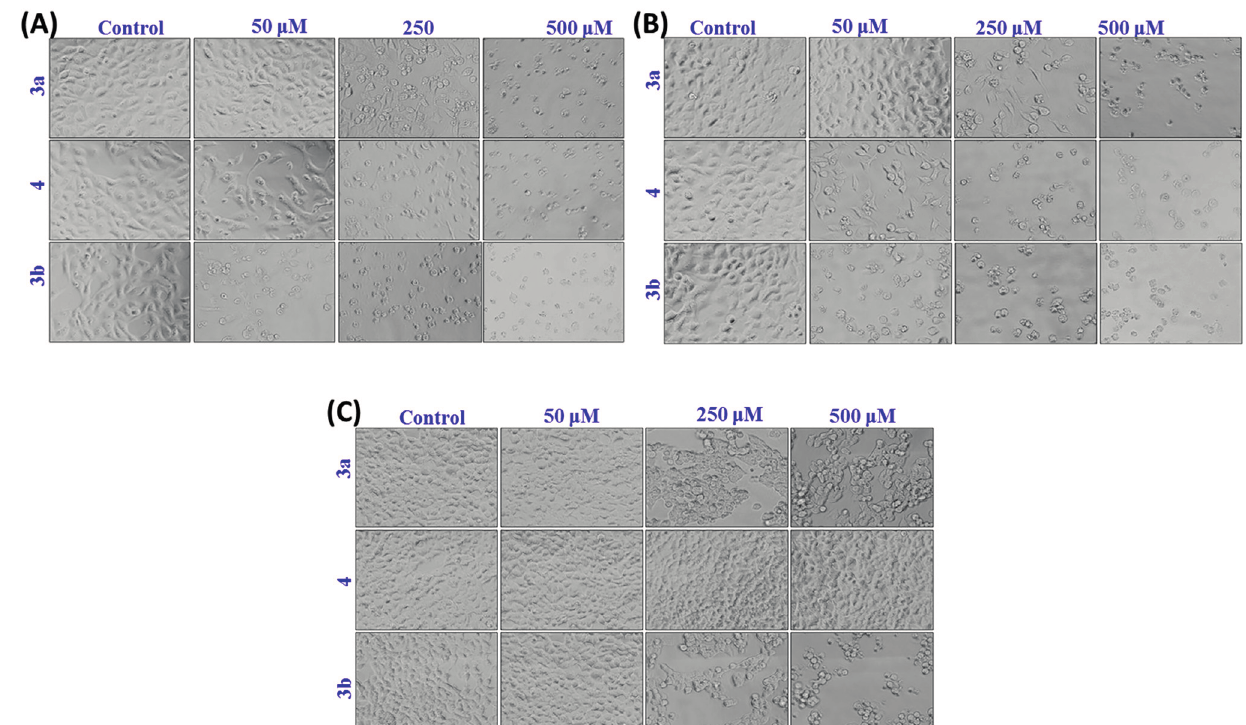
Figure 3. Morphological changes in ( A ) MCF-7 cells, ( B ) HepG2 cells and ( C ) HEK293 cells. The cells were exposed to different concentrations of compounds 3a , 3b and 4 for 24 h. Images were taken using an inverted phase contrast microscope at 20×